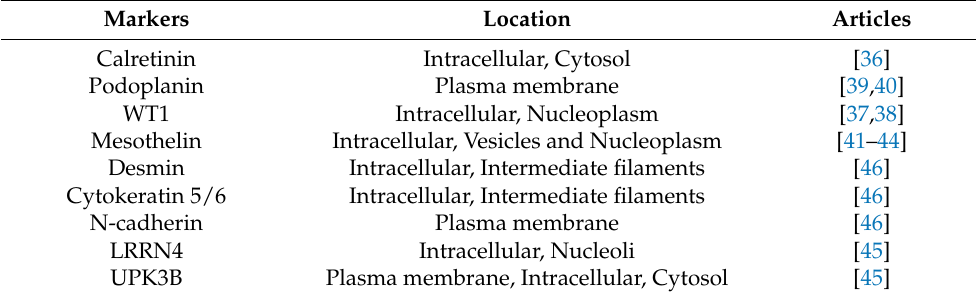
Table 1. Mesothelial markers.